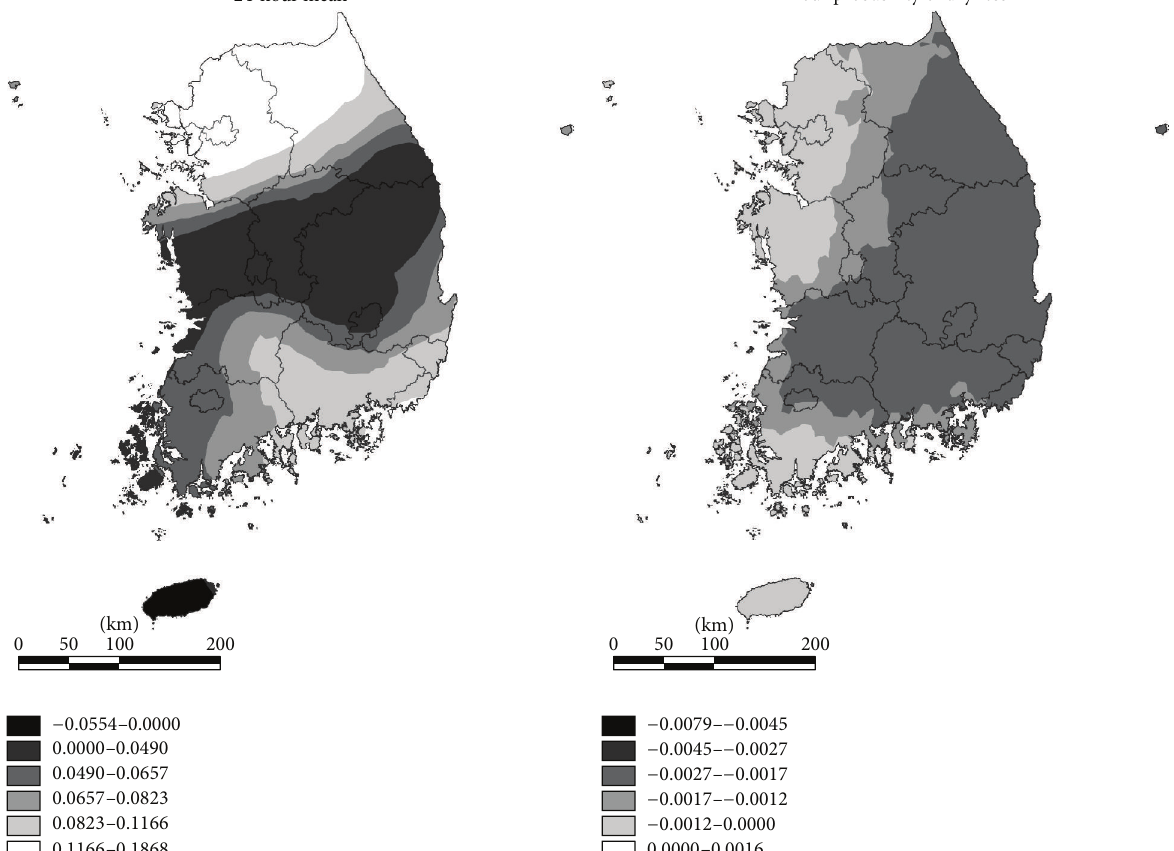
Figure 8: Map of the linear trend of 24-hour precipitation statistics of